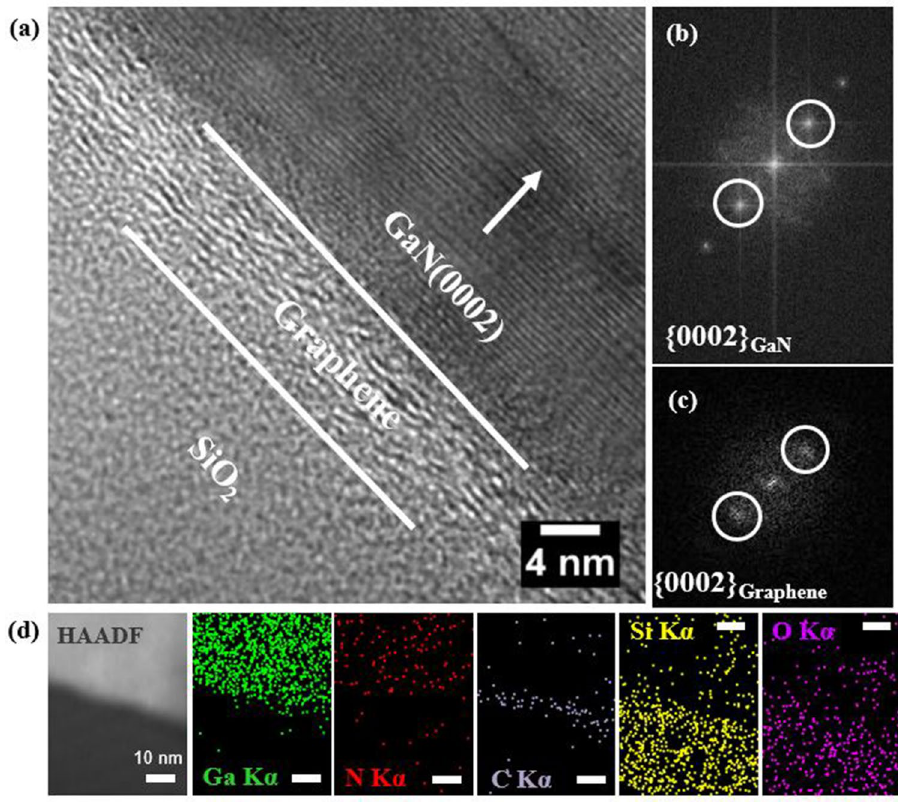
Figure 2. TEM of GaN microstructures on graphene layers; ( a ) Cross-sectional high-resolution (HR) TEM from the sample; ( b ) FFT pattern from GaN layers; ( c ) FFT pattern from graphene film. ( d ) STEM-EDS (cross- sectional view): HAADF image, mapping of Ga, N, C, Si and O